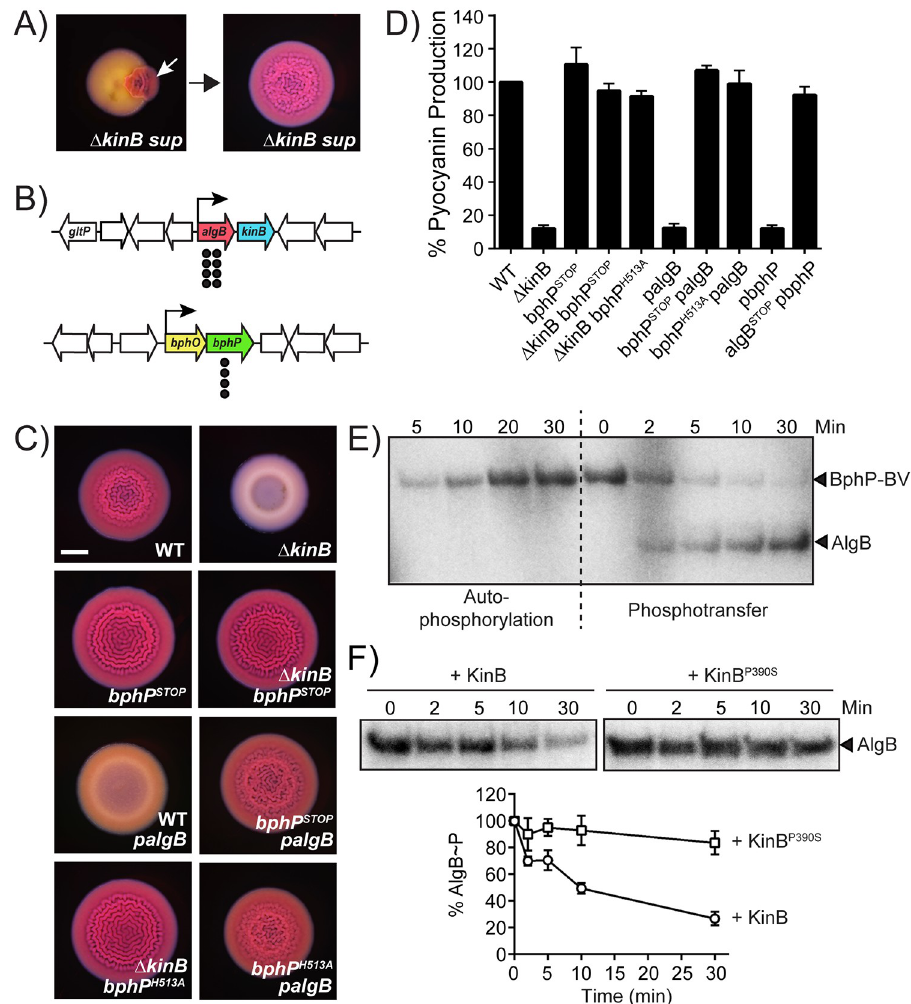
Fig 3. BphP and AlgB are a two-component HK–RR pair. (A) Shown is a representative isolation of a suppressor mutation of the Δ kinB smooth colony biofilm phenotype. The white arrow in the left panel indicates a region of rugose sectoring in the Δ kinB smooth colony biofilm that is diagnostic of the emergence of a suppressor mutation. The right panel shows the colony biofilm phenotype of a mutant following isolation. (B) Chromosomal arrangements of the algB (red), kinB (blue), bphO (yellow), and bphP (green) genes. Large white arrows represent open reading frames (lengths not to scale), black bent arrows indicate promoters, and black circles indicate the locations of suppressor mutations. (C) Colony biofilm phenotypes of WT PA14 and the designated mutants on Congo red agar medium after 72 h of growth. palgB refers to algB under the P lac promoter on the pUCP18 plasmid. Scale bar is 2 mm for all images. (D) Pyocyanin production (OD 695 ) was measured in WT PA14 and the designated mutants. pbphP refers to bphP under the P lac promoter on the pBBR-MCS5 plasmid. Error bars represent SEM for 3 biological replicates. (E) Autophosphorylation of BphP–BV and phosphotransfer to AlgB. (Left) Autophosphorylation of BphP–BV was carried out for 30 min and samples were removed at the indicated times for electrophoresis. (Right) An equimolar amount of AlgB was added to phospho-BphP-BV for 30 min and samples were removed at the indicated times for electrophoresis. (F) Dephosphorylation of AlgB-P by KinB or KinB P390S . Phosphotransfer to AlgB from phospho-BphP-BV was carried out for 30 min. ATP was removed from the reaction, and either KinB or KinB P390S was added. Samples were removed at the indicated times for electrophoresis. The top panel shows representative images of gels. The bottom graph shows percent AlgB-P levels at each time point with SEM for 3 independent replicates. Band intensities for AlgB-P when KinB was added (circles) and when KinB P390S was added (squares) were normalized to the levels at time 0. To assess the quality of protein preparations used in panels E and F, see S4B Fig. Data for the graphs in panels D and F can be found in supplemental file S1 Data. The original autoradiographs with the data for panels E and F are available in supplemental file S2 Data. BV, biliverdin; OD, optical density; SEM, standard error of the mean; WT, wild type.